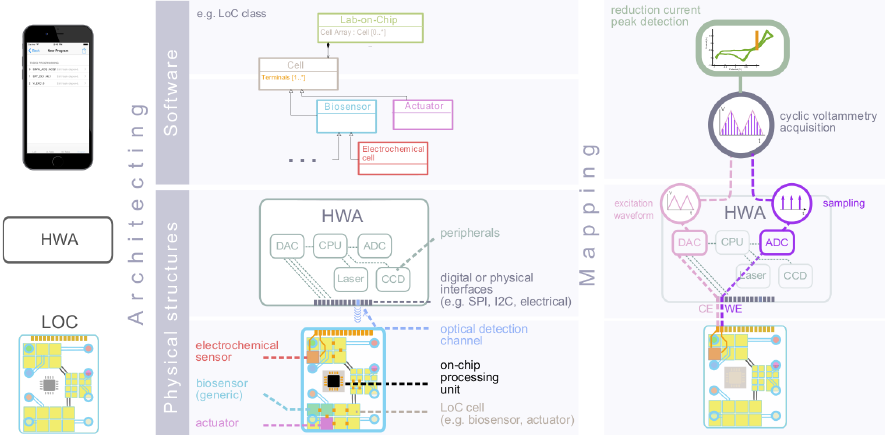
Figure 3. ( a ) Abstraction of the LoC and HWA structural components at the mobile software layer. The physical structures of the LoC and the interfaces enabling their associations are “cyberized” at the mobile software layer [31] in order to enable the definition of LoC variants’ architectures. ( b ) Once both the platform function space and platform architectural space are defined, mechanisms need to be implemented in order to allow the functional allocation of ETs to the relevant structural components of the HWA or LoC: the application